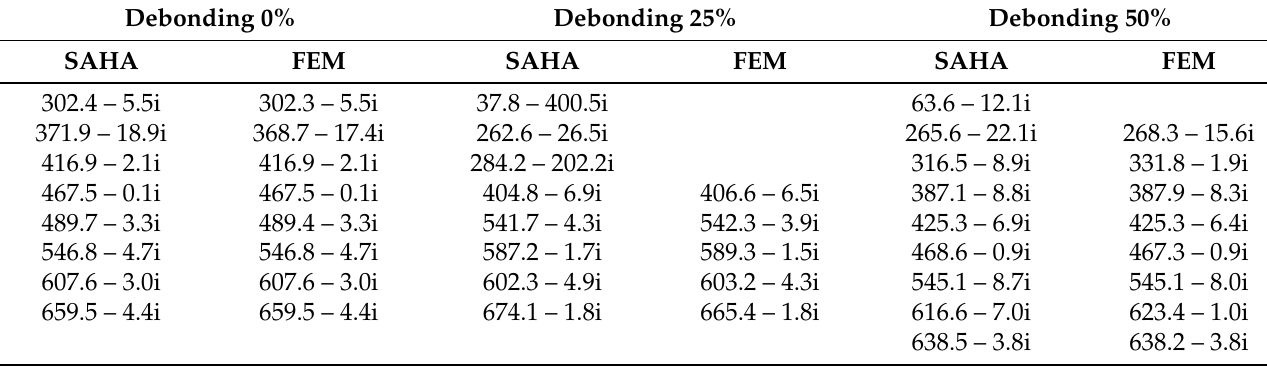
Figure 13. The total transmission coefficient β + ( f ) for the incident S0 and A0 modes scattered by the obstacle of height h = 2 mm ( a ), 5 mm ( b ), 10 mm ( c ), or 25 mm ( d ) and width w = 5 mm, as well as a debonding rate of 0% with a = 0 or a debonding rate of 25% with a = 1.25 mm. Table 2. Eigenfrequencies (kHz) of an H = 2 mm thickness aluminum plate with a rectangular aluminum block debonded on one side ( w = 5 mm width, h = 15 mm